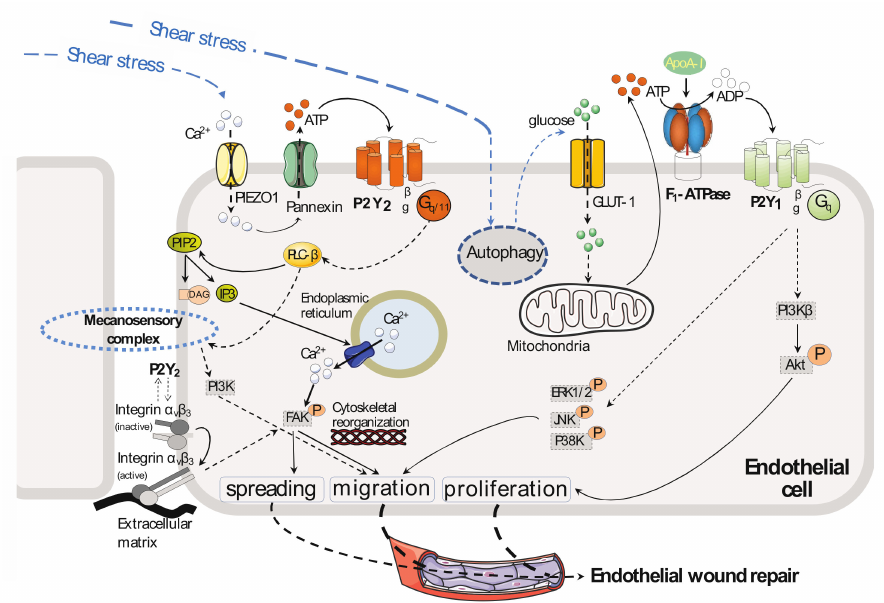
Figure 2. P2Y-R and endothelial cell proliferation, migration, and spreading. Endothelial cells release ATP in response to fluid shear stress, which activates purinergic receptor-mediated endothelial cell alignment, cytoskeletal reorganization, and wound repair. In particular, extracellular ATP stimulates P2Y 2 -R, which subsequently activates phospholipase C- β (PLC β ), generates inositol 1,4,5-trisphosphate (IP3), increases the cytosolic Ca 2+ concentration, and activates focal adhesion kinase (FAK), which mediate cytoskeletal reorganization and the consequent cell migration and spreading. Furthermore, extracellular ATP increases cell migration in a phosphatidylinositol 3-kinase (PI3-K)–dependent manner. ATP also induces increased expression of α v integrin, which plays a role in mediating endothelial cell migration and cell alignment. Extracellular ATP is also hydrolyzed to ADP by ecto-F 1 -ATPase anchored to the plasmatic membrane of endothelial cells, a process that is stimulated by apoA-I, which is the main HDL apolipoprotein. The newly generated extracellular ADP stimulates P2Y 1 -R, which subsequently activates mitogen-activated protein kinase pathways, as evidenced by increased phosphorylation of extracellular signal-regulated kinase (ERK)1/2, c-Jun N-terminal kinase (JNK), and p38 kinase. These signaling events promote endothelial cell migration. P2Y 1 -R activation by ADP also induces activation of the PI3K β isoform and subsequent endothelial cell proliferation. Overall, these mechanisms contribute, in vitro, to endothelial wound repair, and they may contribute, in vivo, to reendothelialization and angiogenesis. Mechanosensory complex: PECAM-1, VE-Cadherin,